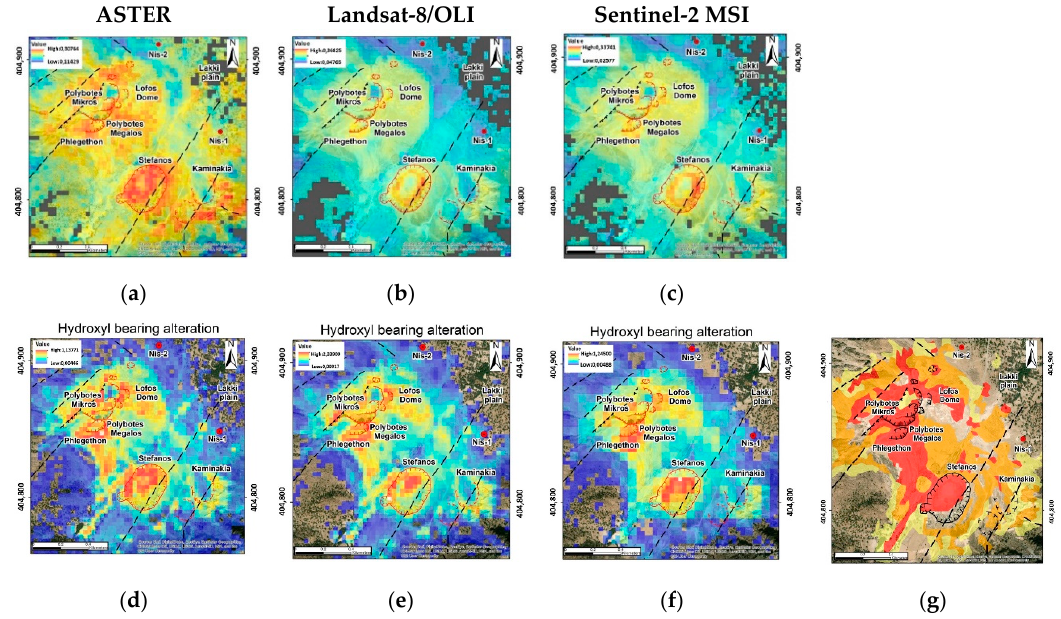
Figure 6. Top row: ( a ) alteration SI (NHASI) map, ( b ) hydroxyl-bearing alteration abundance map calculated from ASTER dataset; second row: ( c ) alteration SI (NHASI) map, ( d ) hydroxyl-bearing alteration abundance map calculated from Landsat-8/OLI dataset; third row: ( e ) alteration SI (NHASI) map, ( f ) hydroxyl-bearing alteration abundance map calculated from Sentinel-2 MSI dataset. Bottom row ( g ): reference map (in red: strong alteration >50%, in orange: 25%–50% middle alteration, and in yellow: 0–25% weak alteration) (Source: [68]).